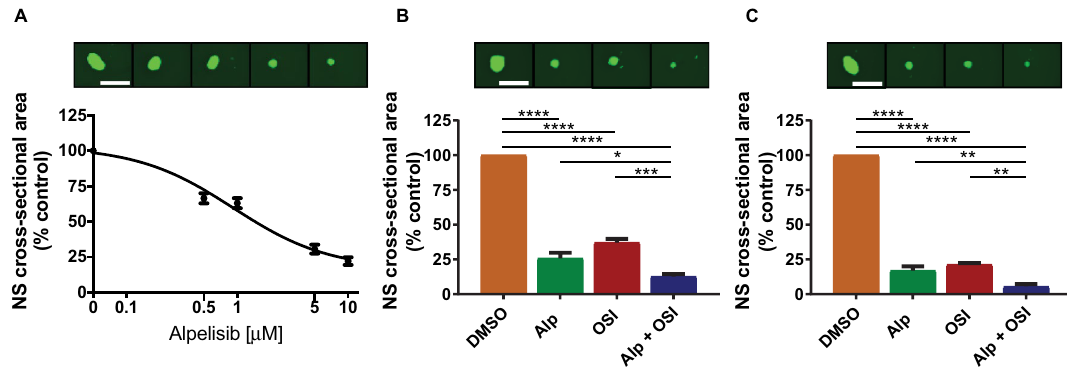
Figure 2. Effects of dual PI3Kα and mTOR inhibition in GBM spheroids. ( A ) U87 GBM cells were grown as spheres in CSC medium for at least 5 days. Spheres were dissociated and seeded at 500 cells/well into round- bottom 96-well plates in the presence of increasing concentrations of alpelisib as indicated. After 7 days, spheres were stained with acridine orange and imaged to determine cross-sectional area. Data represent means ± SEM of 5 independent experiments, each done in triplicate. Representative images are shown in the top panels. ( B , C ) Same experiment as in ( A ) using 5 µM alpelisib and 1 µM OSI-027 ( B ) or 10 µM alpelisib and 2 µM OSI-027 ( C ). Data represent means ± SEM of 6 independent experiments, each done in triplicate. Representative images are shown in the top panels. Unpaired one-way ANOVA, * p ≤ 0.05; ** p ≤ 0.01; *** p ≤ 0.001; **** p ≤